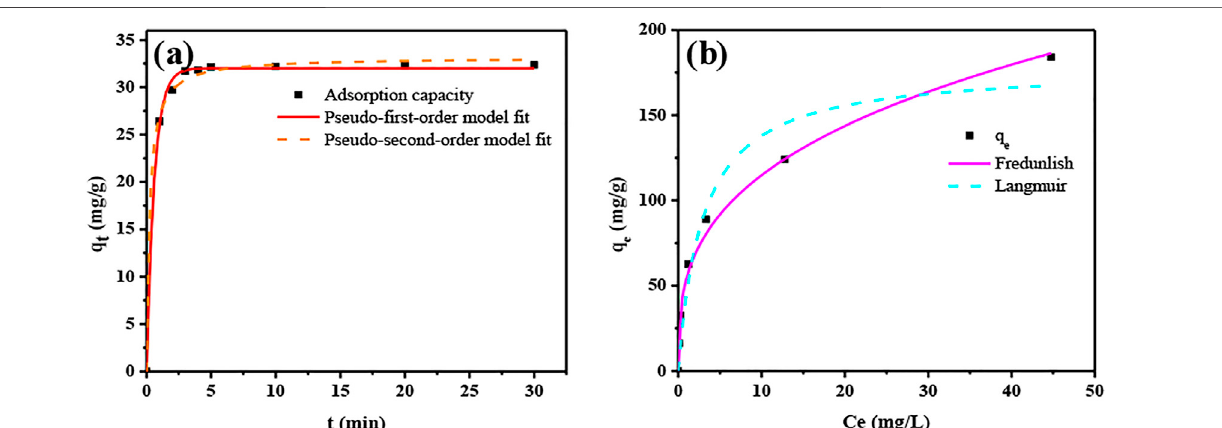
FIGURE 4 | Kinetic and thermodynamic fi tted curve. (A) Kinetic fi tted curve, (B) thermodynamic fi tted curve.